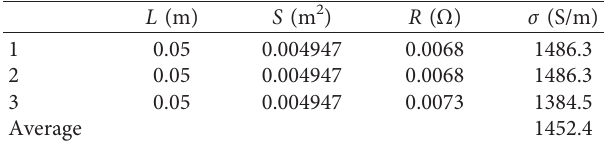
Table 2: Electrical conductivity data of the carbon/carbon fiber composite (plane